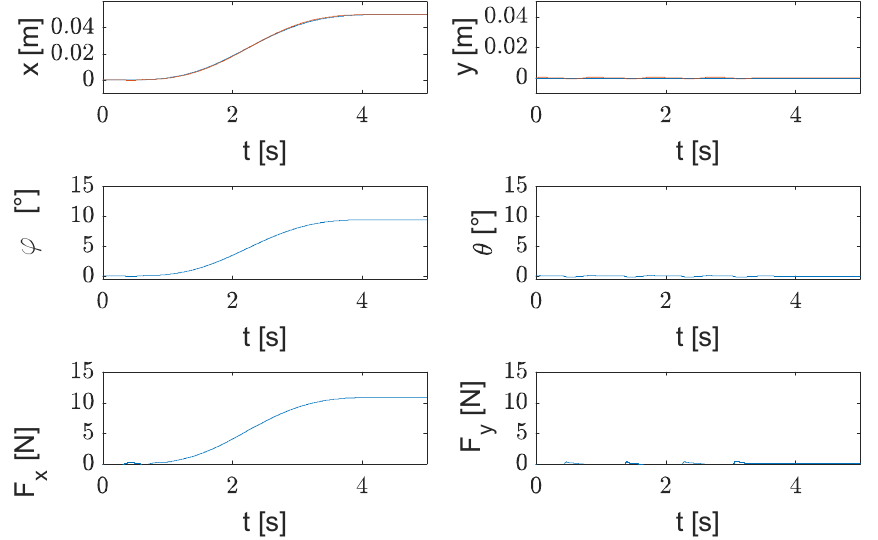
Figure 25. Response for an abduction movement φ = 9.45°, x = 0.05 m, with disturbance.